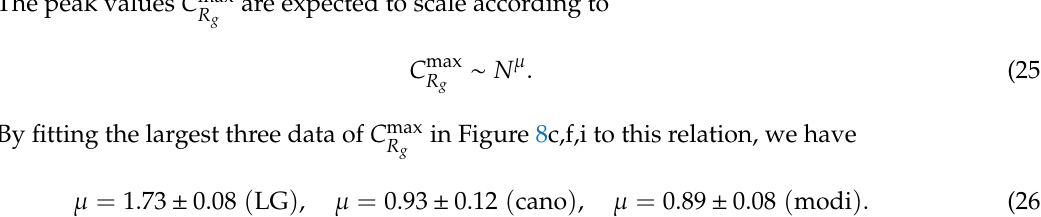
Figure 8. The mean square gyration R 2 g , its variance C R N for ( a –c) the LG model, ( d – f ) the canonical model, and ( g – i ) the modified canonical model. The peak values C max are expected to scale according R g